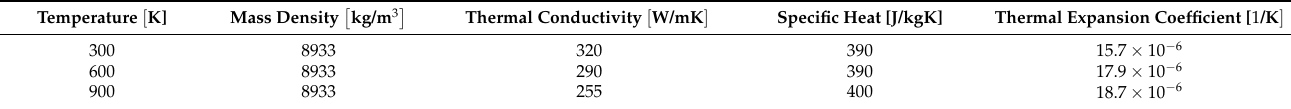
Table 2. Thermal and physical properties of CuCrZr alloy [6].